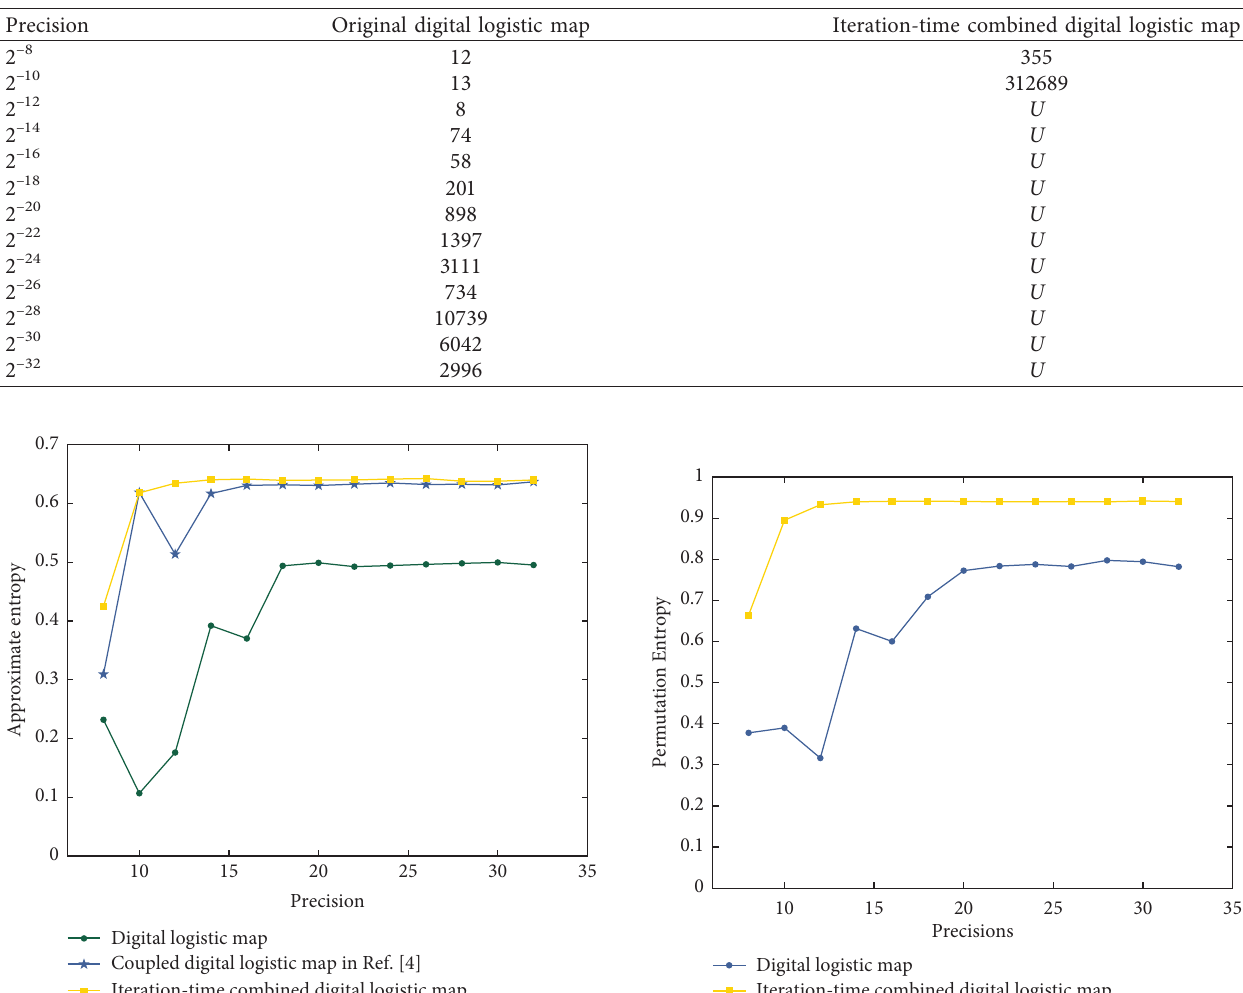
Figure 3: Auto-correlation function of two maps. (a) Digital logistic sequence; (b) iteration-time combined digital logistic sequence. Table 1: Period analysis of two maps ( U denotes undetected).